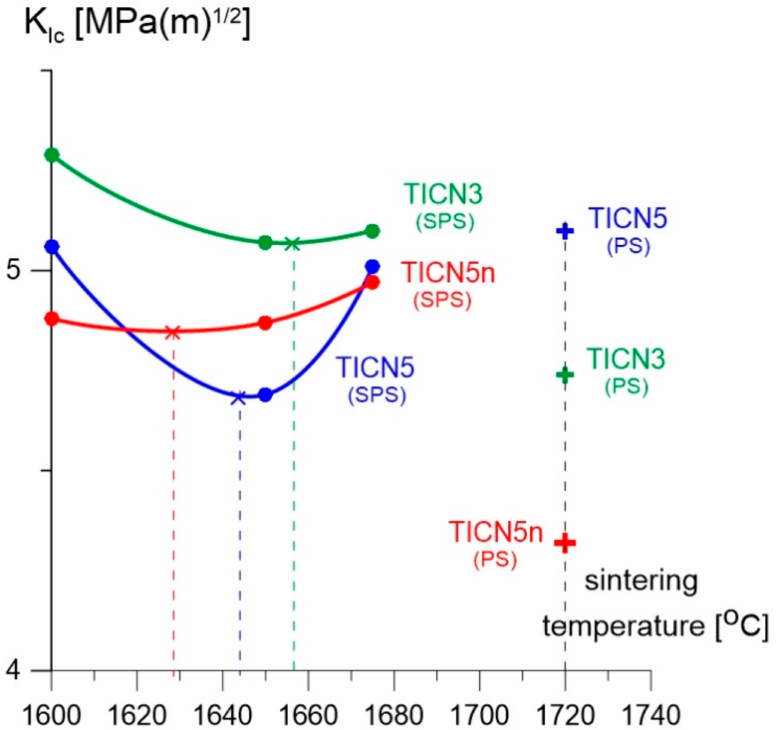
Figure 6. The relationship of K IC and temperature of the samples sintered using SPS and pressureless sintering